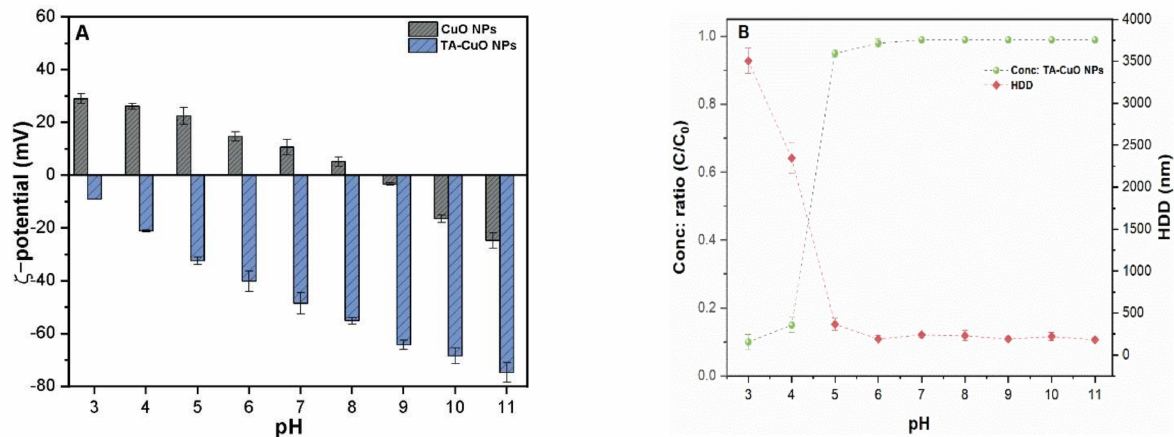
Figure 3. Under different solution pH levels: ( A ) ζ -potential of CuO NPs with and without TA; ( B ) colloidal stability and HDD of the TA-CuO NPs. The concentration ratio C/C 0 indicates the colloidal stability of TA-CuO NP